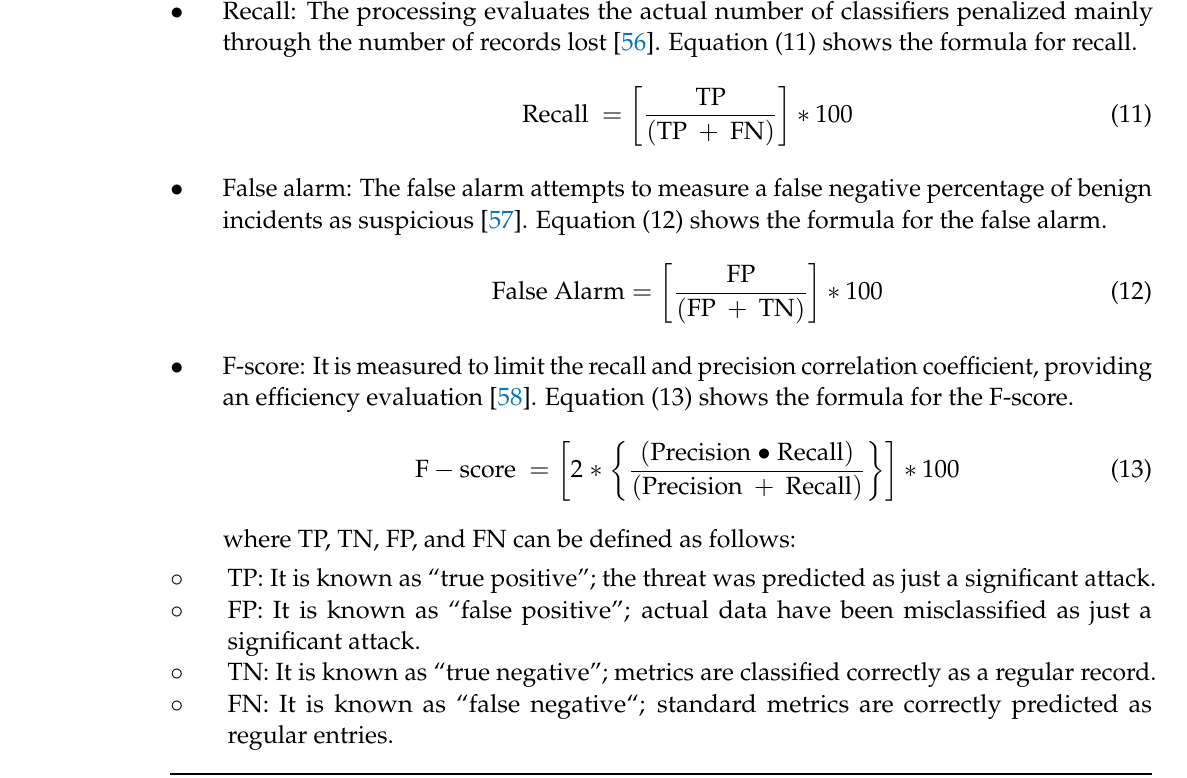
Algorithm 2. Proposed HNIDS method (IRF